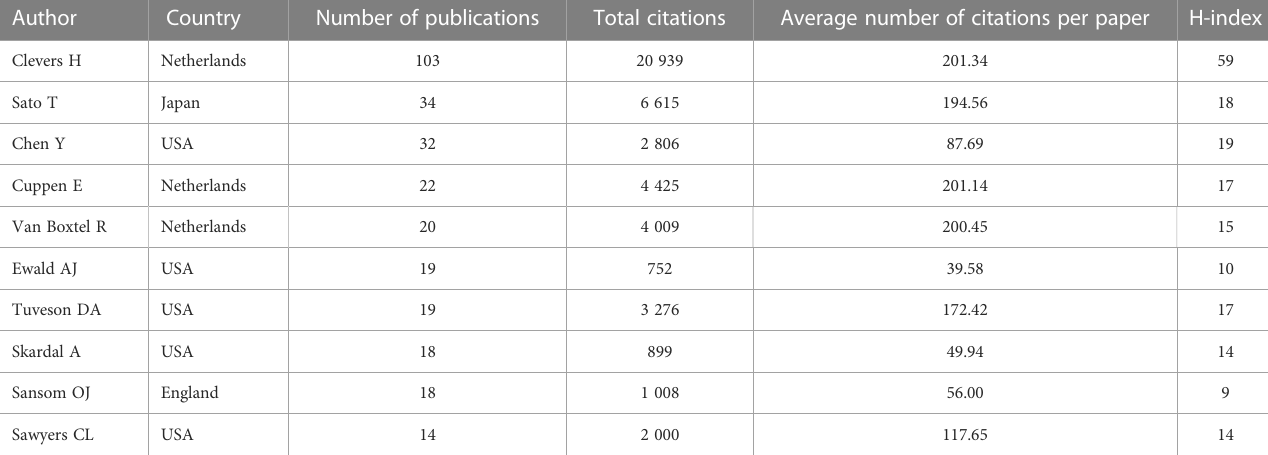
TABLE 4 Productivity, citations and H-indices of the top ten authors of tumor organoid